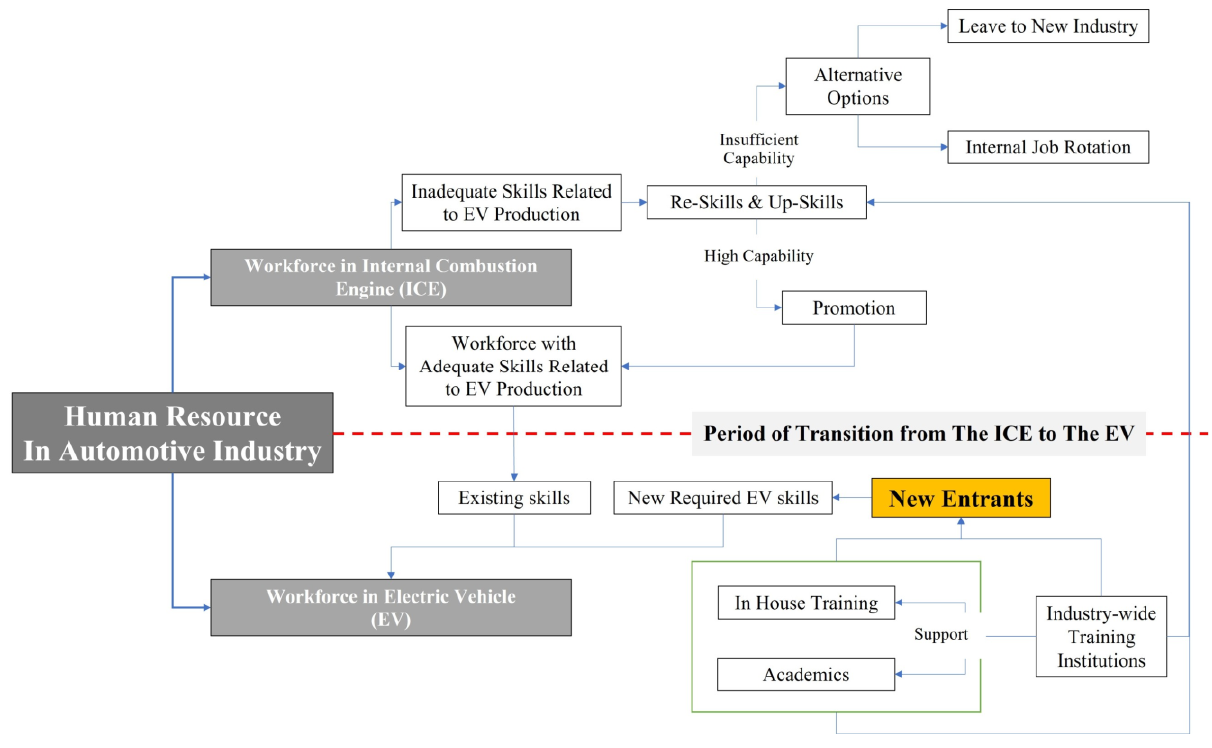
Figure 3. The pathway of human resource development in EV production. Source: developed by authors according to fieldwork interviews.